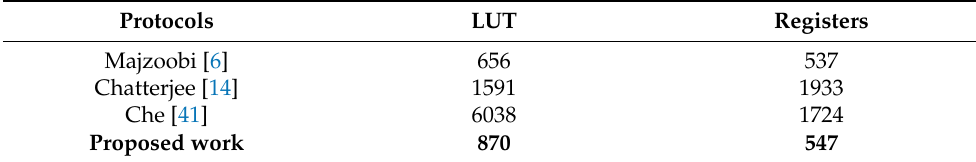
Table 2. Comparison with other protocols’ execution costs.